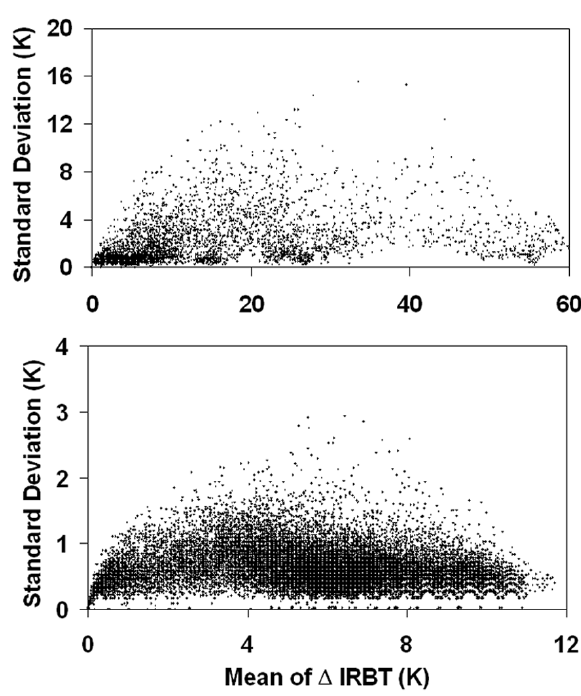
Fig. 5. Arch diagrams for a 3 × 3 pixel array of a 60 × 60 pixel box from a Difference Image (DI) and their classification according to the cloud algorithm. An example of an arch without a clear foot classified as fully cloudy (top panel) and an arch classified as fully clear (bottom panel).